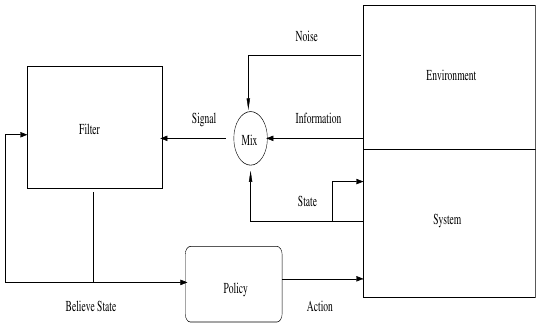
Figure 1. Stylized implementation of the control flow within a realistic application.